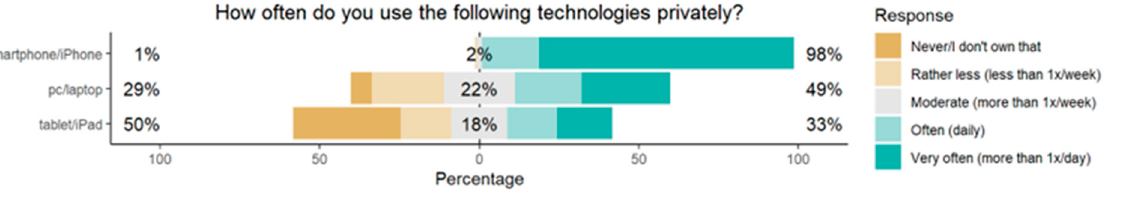
Figure A2. n = 329. Nine subjects were excluded since they did not answer the question fully. Shown above are the participants’ responses regarding privately, i.e., separate from work used technologies. Deviations in the direction of approval and rejection are shown on the right or left in percentual frequencies.